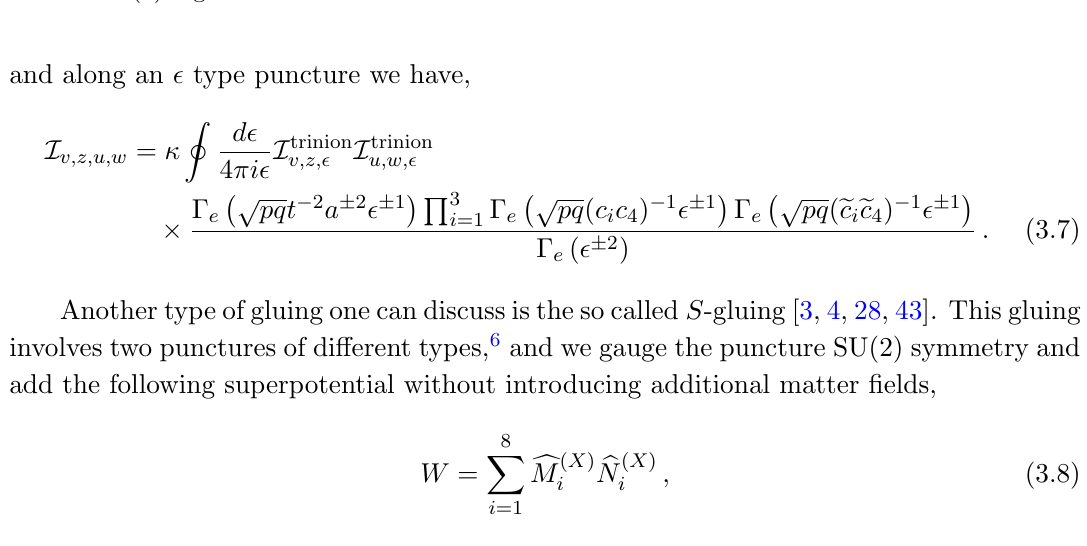
Figure 4 . Di(cid:11)erent duality frames for a four punctured sphere. The fact that the left and right frames are the same implies for example that the index has to be invariant under the exchange of the two SU(2)